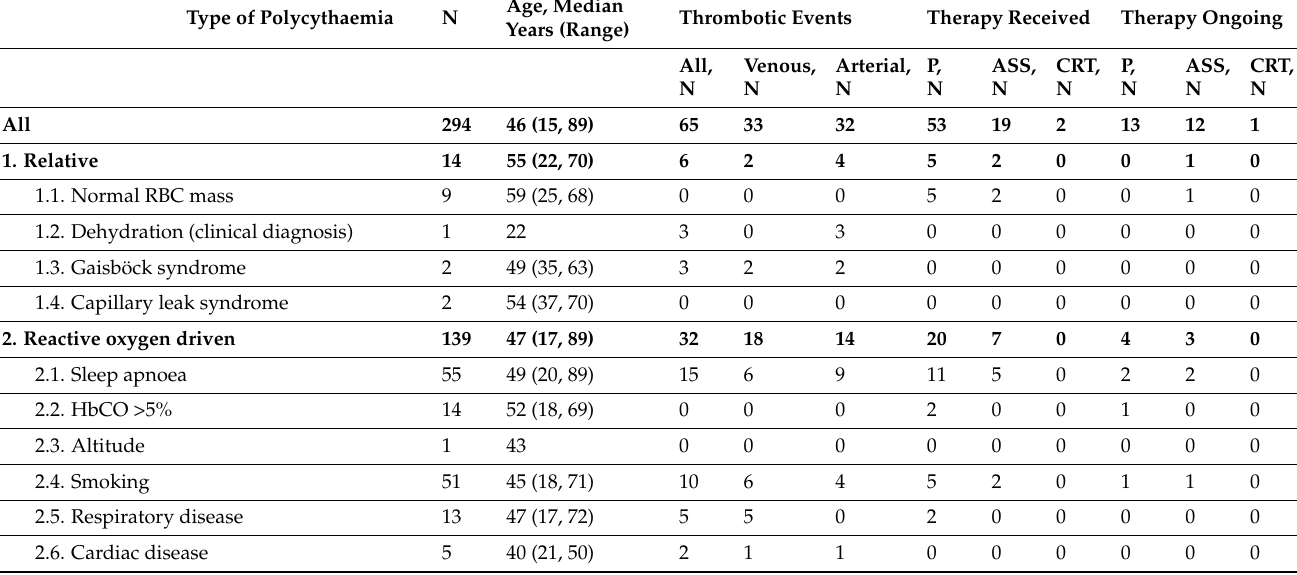
Table 2. Thrombotic events and therapy during follow-up in JAK2 unmutated polycythaemia patients, N =